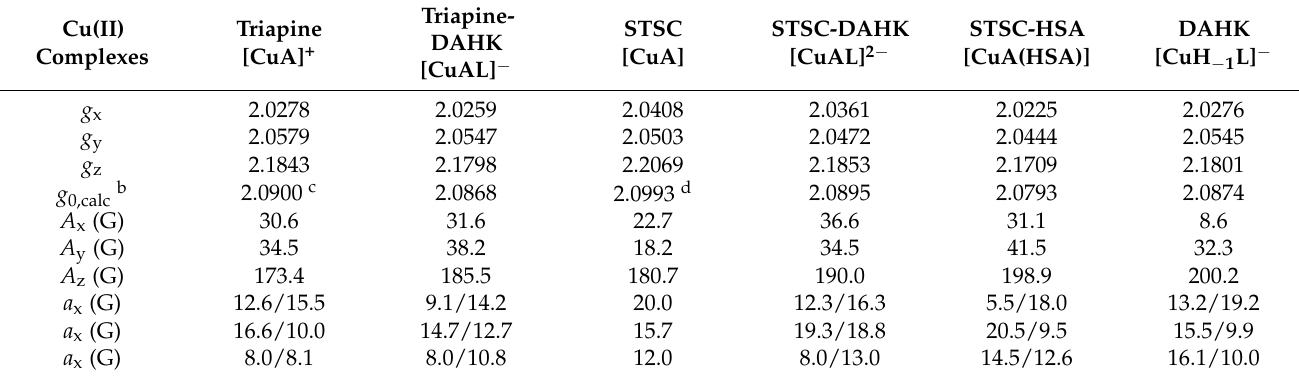
higher excess of N-methylimidazole was needed (>10) in comparison to DAHK; however, two overlapping processes were observed (Figure 4c). Anisotropic EPR parameters calculated for the various species formed in the binary copper(II)- Triapine/STSC/DAHK and ternary copper(II)-Triapine/STSC (A)-DAHK (L)/HSA systems in 30% ( w / w ) DMSO/H 2 O at